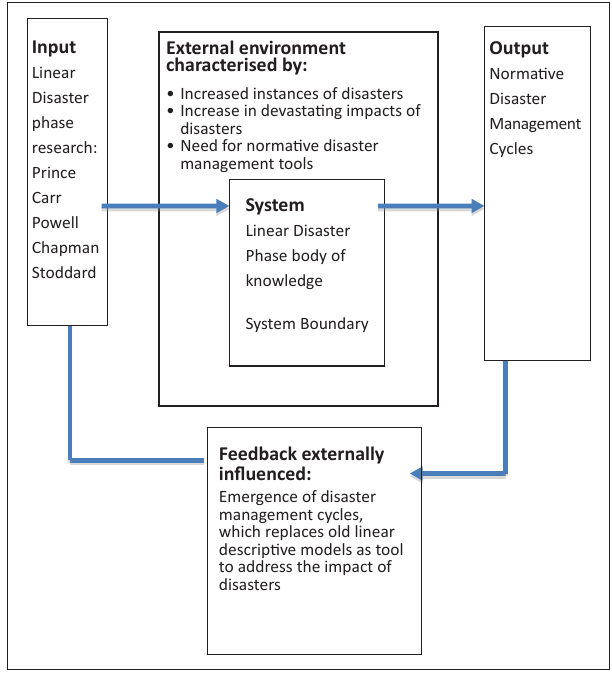
FIGURE 3: Feedback arrangement illustrating the origins of the disaster management